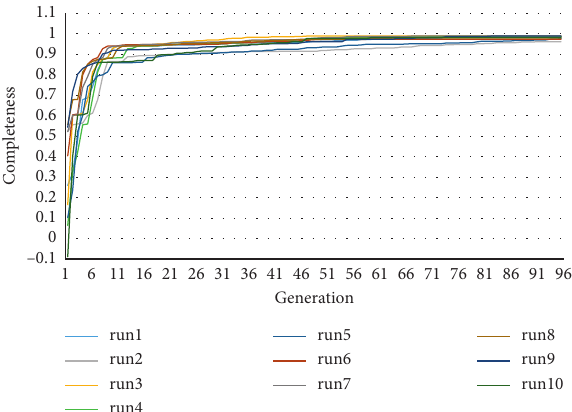
Figure 9: The completeness curves for 10 runs on